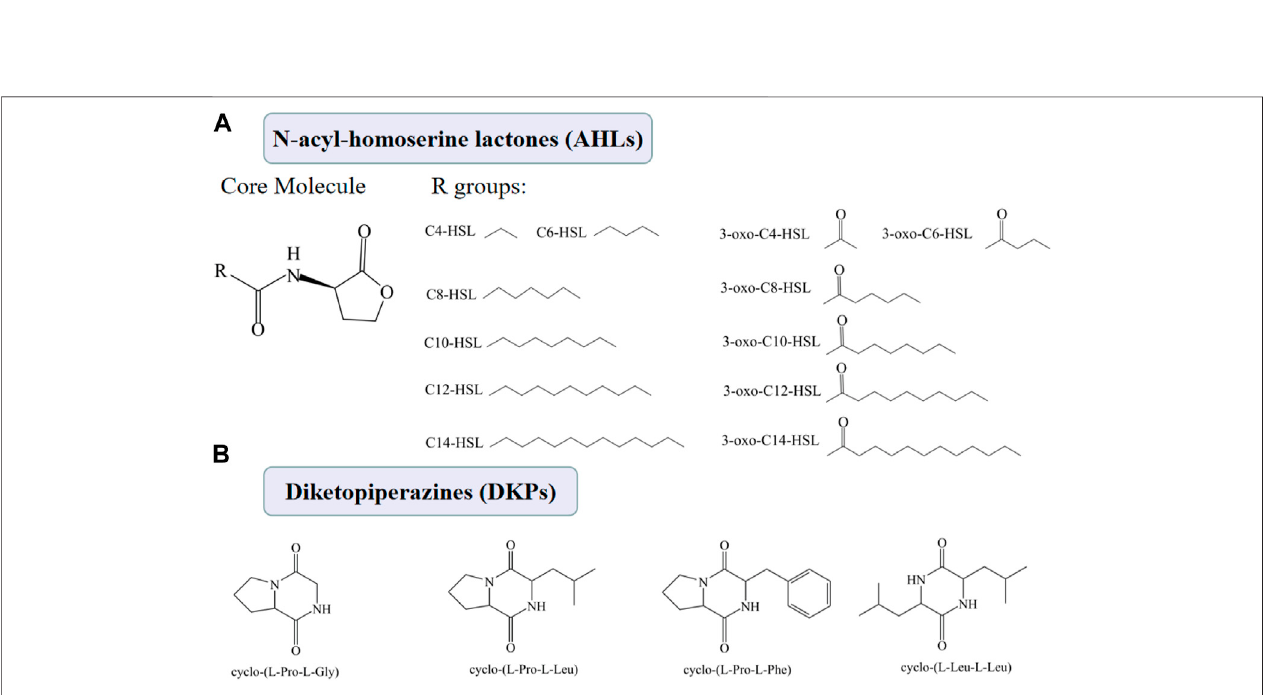
FIGURE 3 | Schematic representation of the QS mechanisms of the major SSOs in aquatic products.